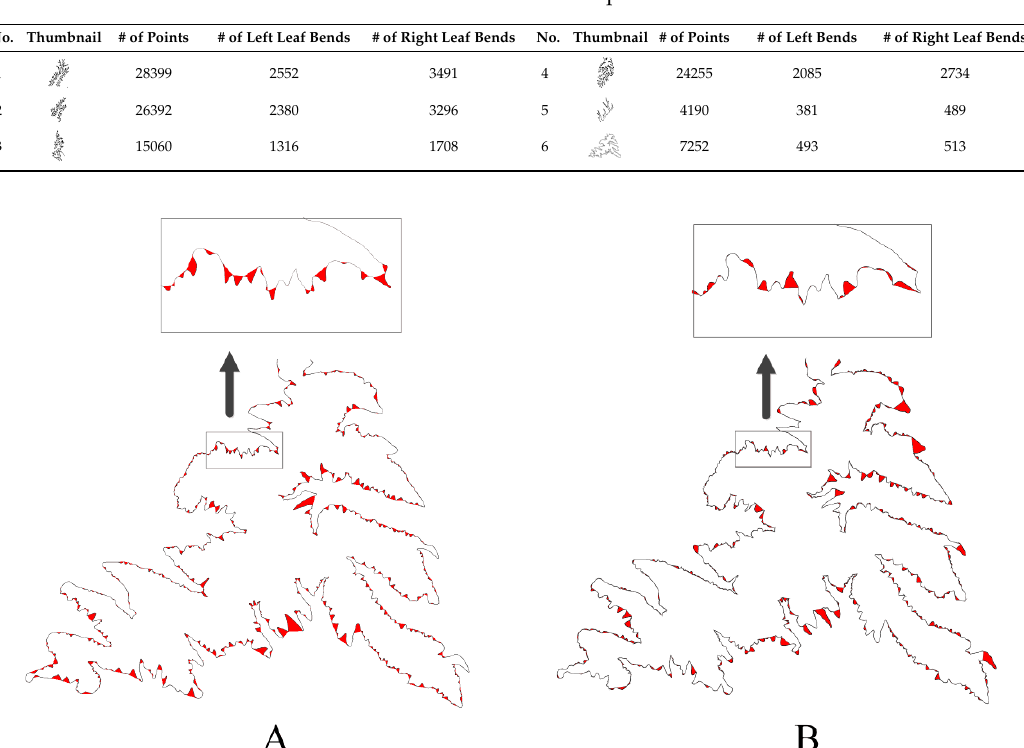
Table 2. Parameters for some of the experimental curves.